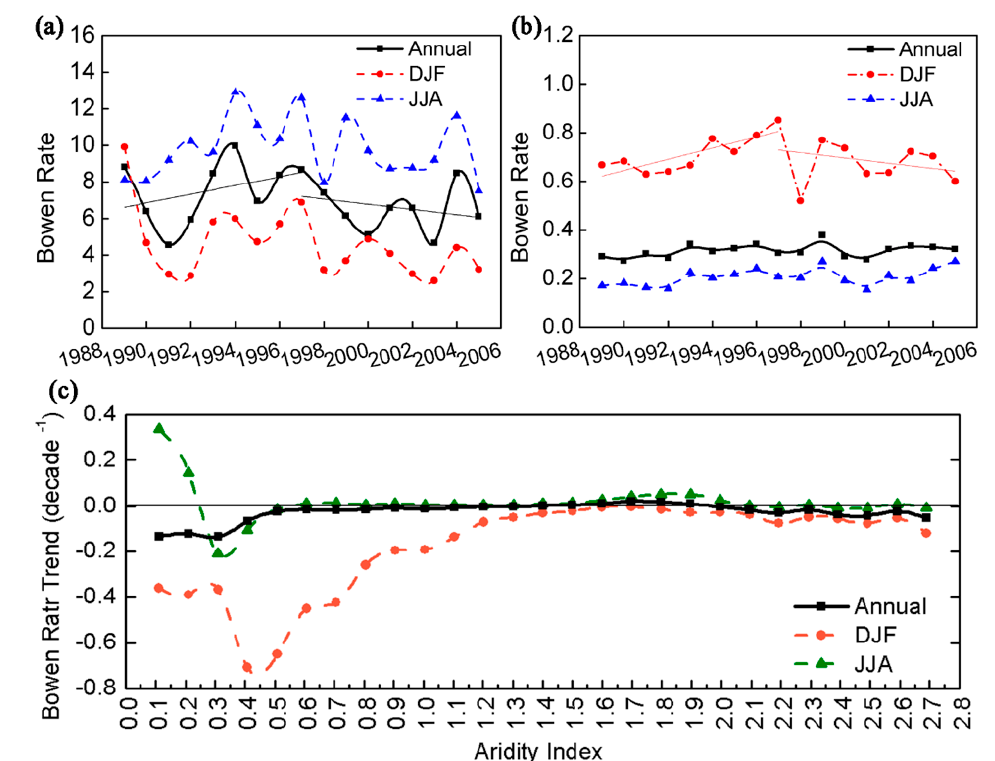
Figure 12. The evolution of the annual Bowen rate in the water-control ( a ) and energy-control ( b ) regions. The annual Bowen rate MK trends as a function of the AI during 1989–2005 ( c ). The black solid lines represent the annual average anomalies, the red dotted lines show the winter averages, and the blue dotted lines indicate the summer averages. The black line segments are the lines fitted to the ET anomalies before and after 1998.